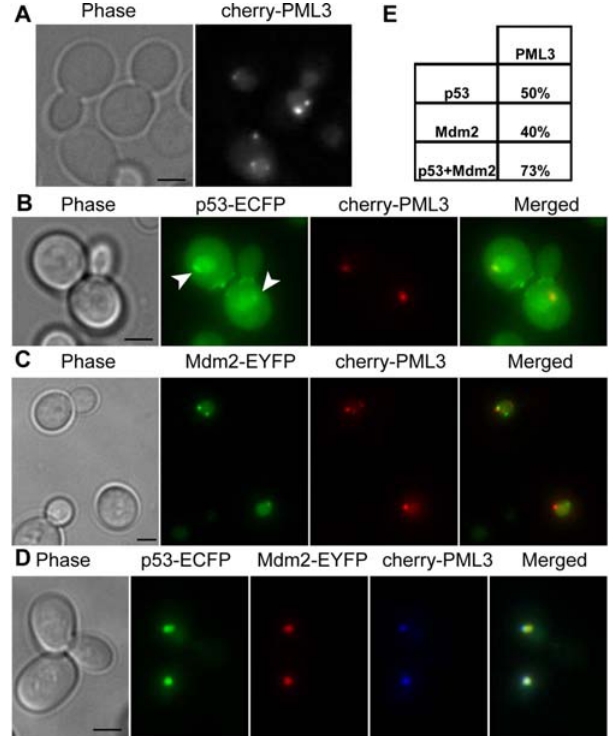
Figure 5. The human PML protein can relocate to the p53-Mdm2 bodies in yeast. (A,B,C,D) Maximum projections from fluorescence image stacks of live yeast cells expressing the indicated fusion proteins were obtained with a DeltaVision workstation. Bar, 2 m m. (E) Table showing the percentage of cells in which the indicated proteins co- localize. Percentages were calculated from more than 100 cells each.